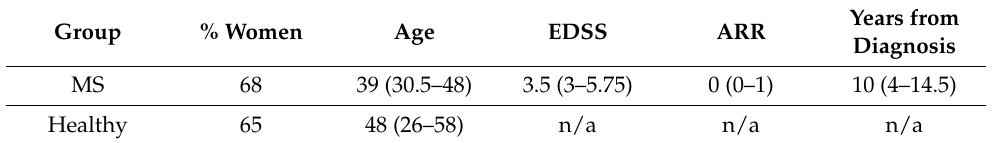
Table 1. Basic clinical and sociodemographic data about study participants. Data are presented as median, IQR. EDSS—expanded disability status scale, ARR—annual relapse rate.